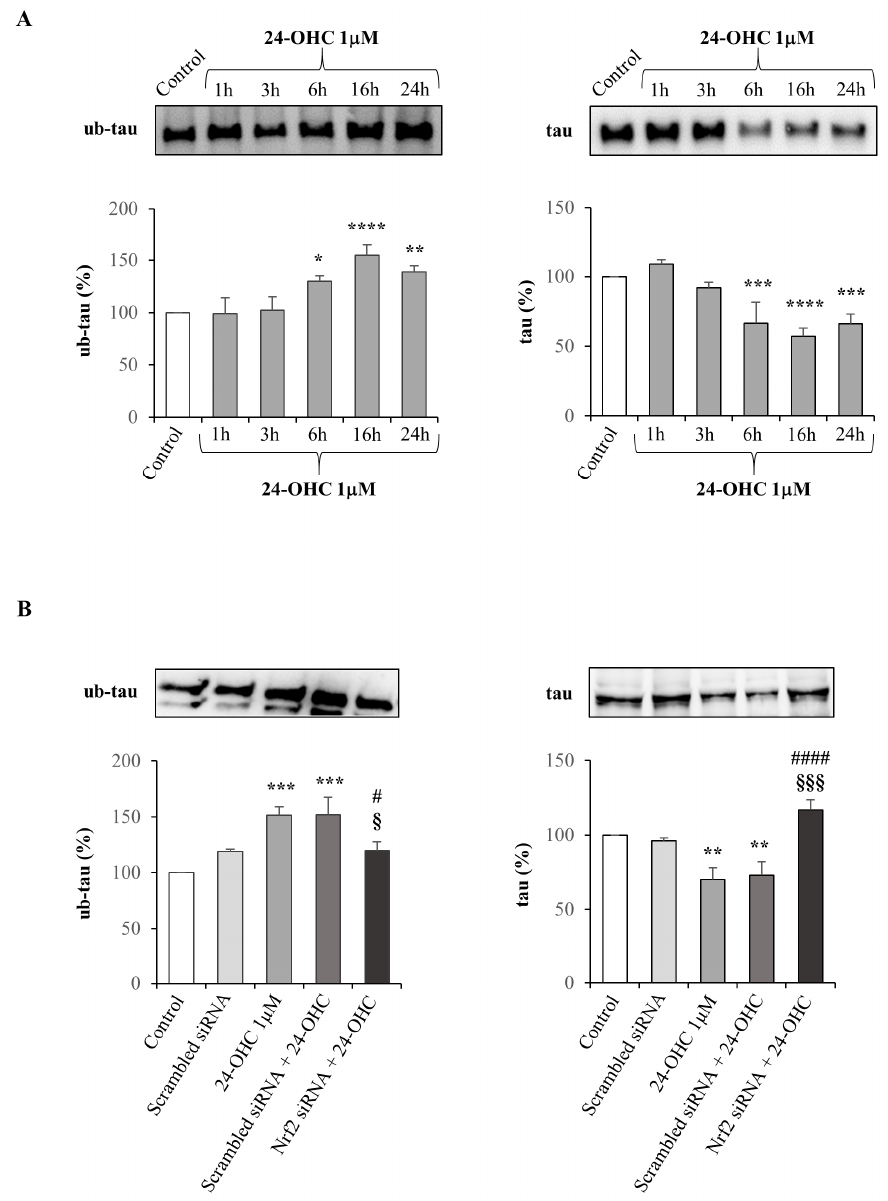
Figure 5. Effect of 24-OHC on the levels of ubiquitinated and total tau, and Nrf2-dependent tau ubiquitination in SK-N-BE cells. ( A ) Ubiquitinated tau (ub-tau) and total tau protein levels were analyzed by Western blotting in cells treated with 24-OHC up to 24 h. Representative blots are shown. The histograms represent mean values ± SD of three experiments. Densitometric measurements are expressed as percentage of control value. * p < 0.05, ** p < 0.01, *** p < 0.001, **** p < 0.0001 vs. control. ( B ) Ubiquitinated tau (ub-tau) and total tau protein levels were analyzed in cells transfected for 6 h with Nrf2 or scrambled siRNA and then treated with 24-OHC (1 μ M) for 24 h. Representative blots are shown. The histograms represent mean values ± SD of three experiments. Densitometric measurements are expressed as a percentage of the control value. ** p < 0.01, *** p < 0.001 vs. control; # p < 0.05, #### p < 0.0001 vs. 24-OHC; § p < 0.05, §§§ p < 0.001 vs. scrambled siRNA + 24-OHC.